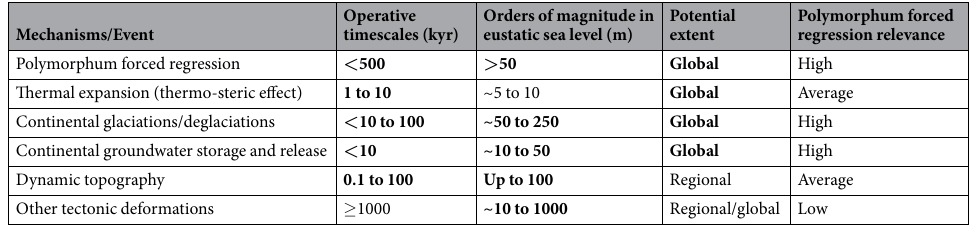
Table 1. Overview of potential mechanisms that may or may not have influenced sea-level change during the Polymorphum Zone. The characteristics in common with the Polymorphum regression event are represented in bold (modified from Sames et al . 75